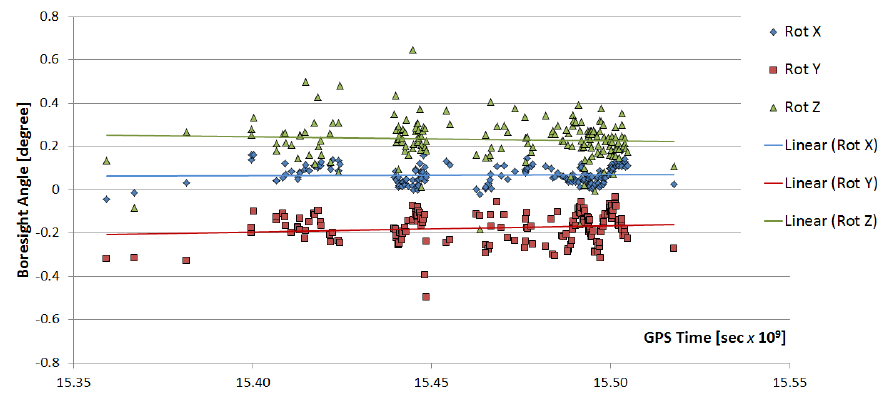
Figure 23. Estimated boresight angles of the DESIS sensor with respect to the body coordinate frame. The three angles as well as the trend lines are plotted against the acquisition time of the